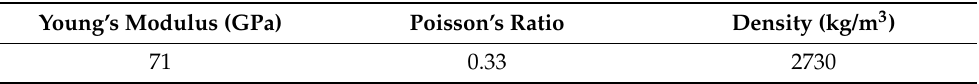
Table 1. Mechanical properties of aluminum alloy.